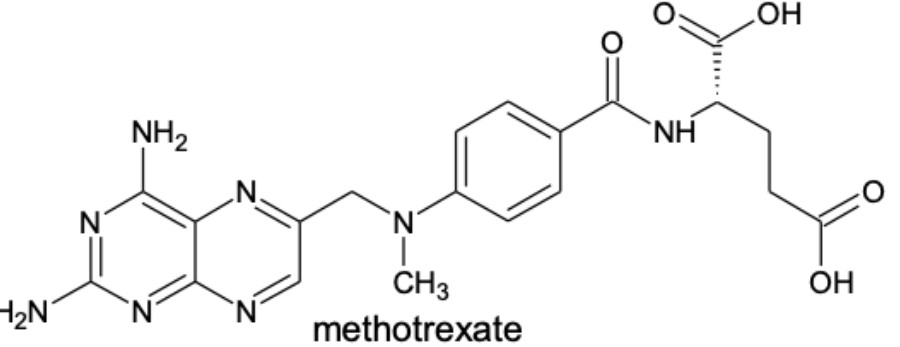
Figure 2. Chemical structure of methotrexate.